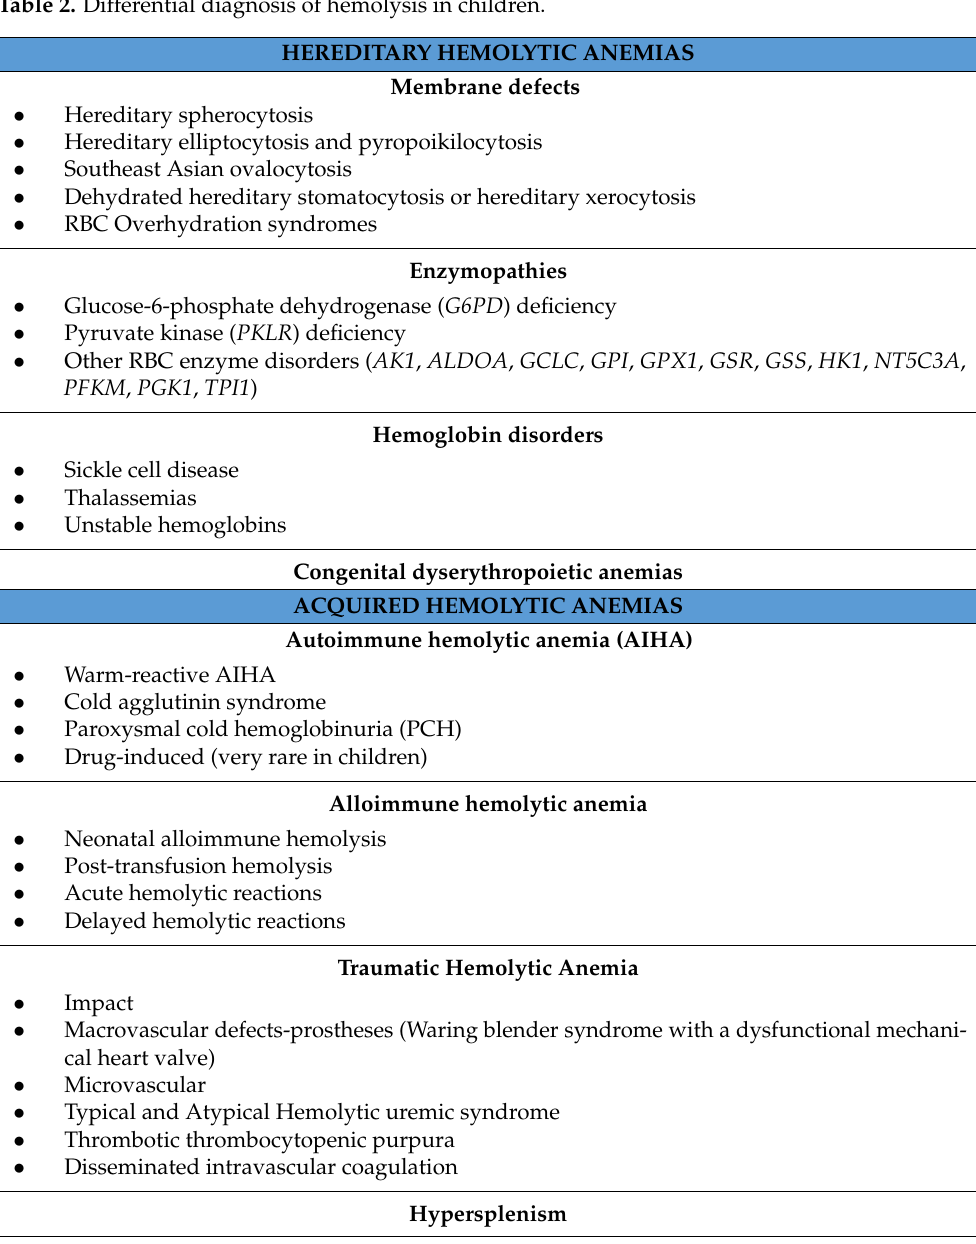
Table 2. Differential diagnosis of hemolysis in